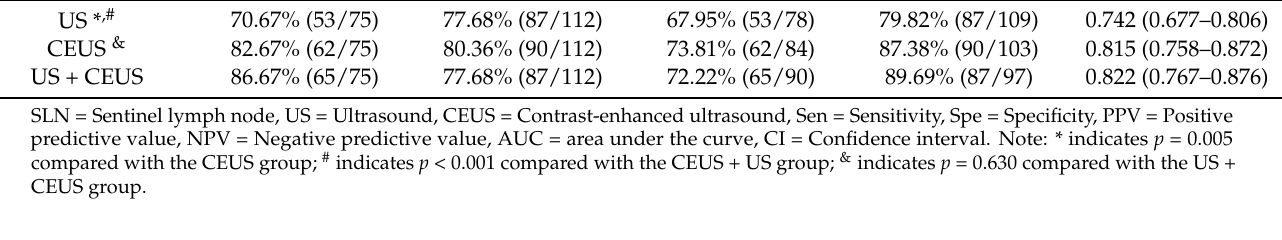
Table 3. Comparison of diagnostic performance of US, CEUS, and US + CEUS for SLN status. Methods